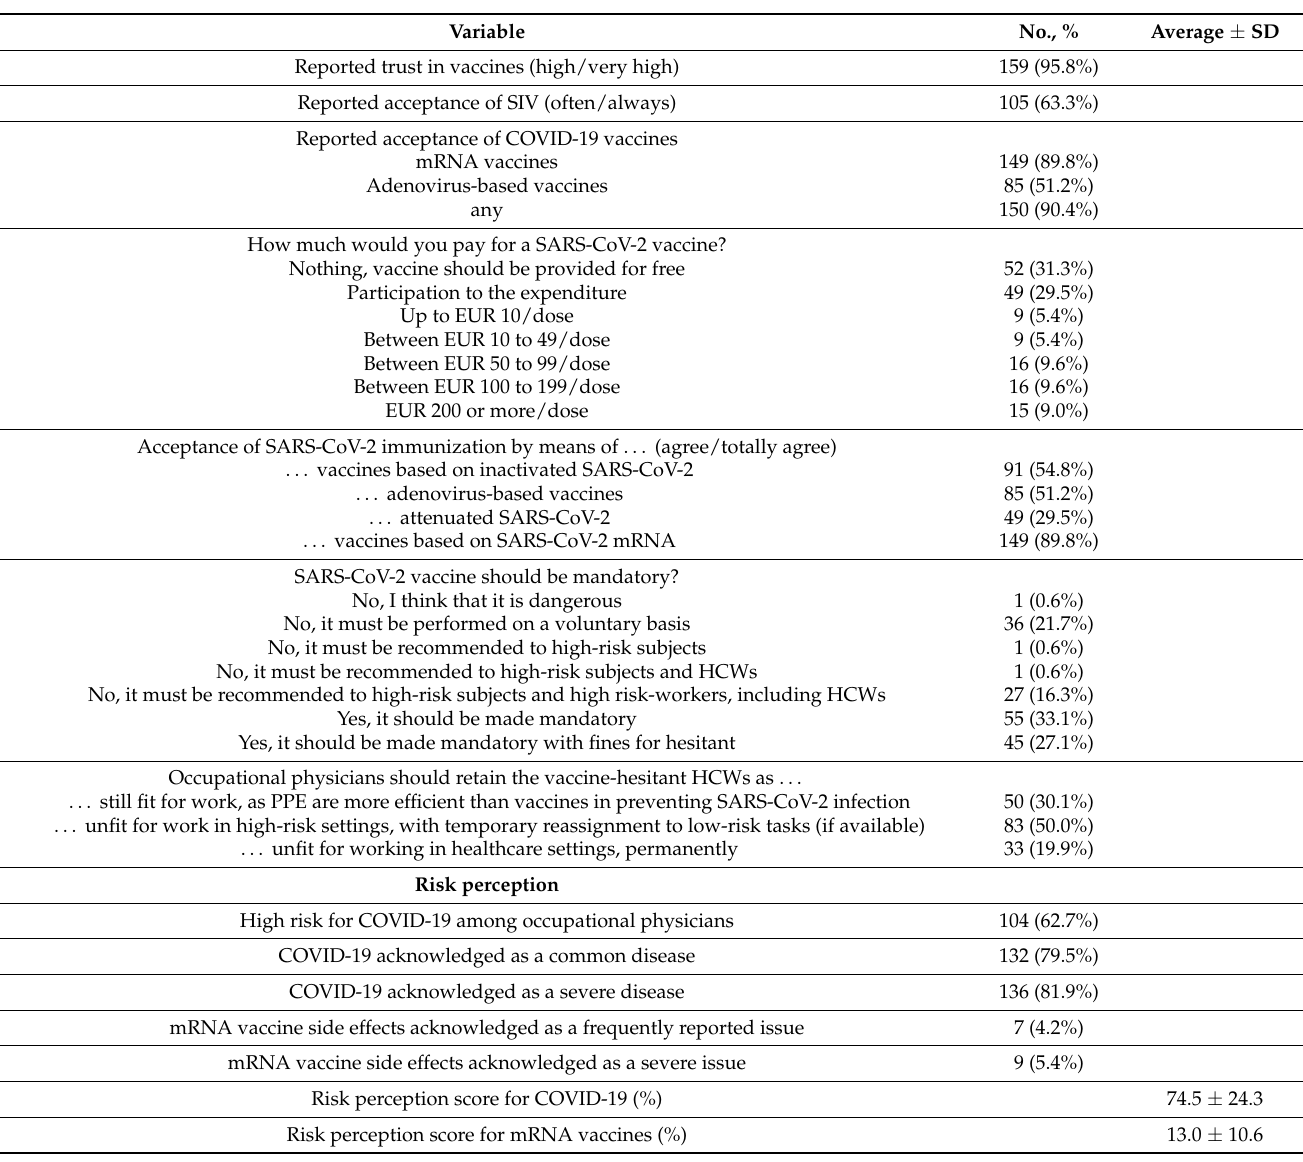
Table 3. Attitudes and practices of 166 OPs participating in the survey on COVID-19 vaccines (Italy, January 2021). Variable No., % Average ± SD Reported trust in vaccines (high/very high) 159 (95.8%) 105